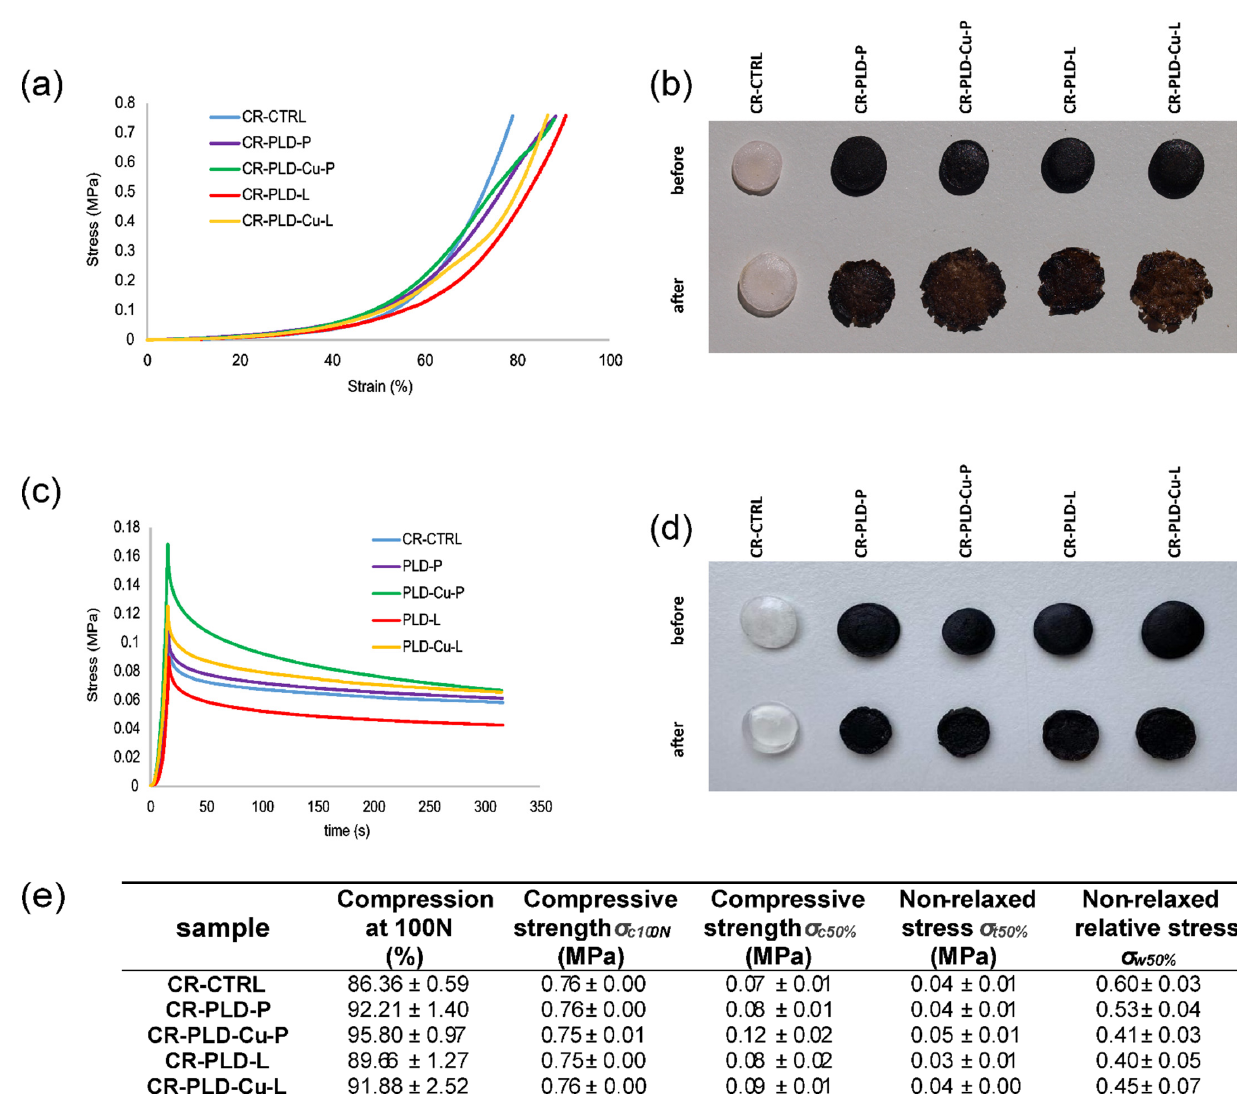
Figure 6. Mechanical properties of control and PLD + oxidoreductases-modified hydrogels. ( a ) representative stress–strain curves for compression to 100N; ( b ) images of the specimens before and after compression to 100N; ( c ) representative stress–strain curves for compression to 50% and relaxation; ( d ) images of the specimens before and after relaxation; ( e ) mechanical parameters of the hydrogels.